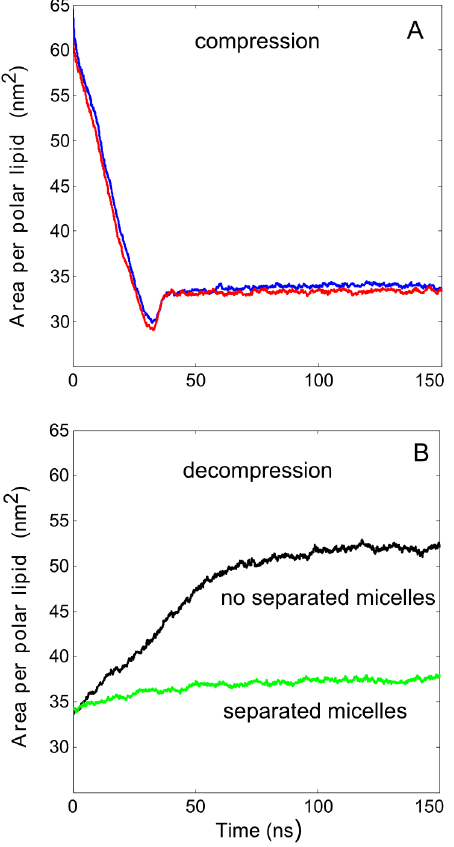
Figure 7. The area per polar lipid as a function of simulation time in non-equilibrium simulations of lateral compression. The lateral pressure of 1 bar was used, each curve represents an independent MD trajectory (A); and decompression under the lateral pressure of at 2 6 bars (B) with the decompression simulation initiated either prior (black curve) or after (green curve) the inversed micelles separated from the polar monolayer in a previous simulation of lateral